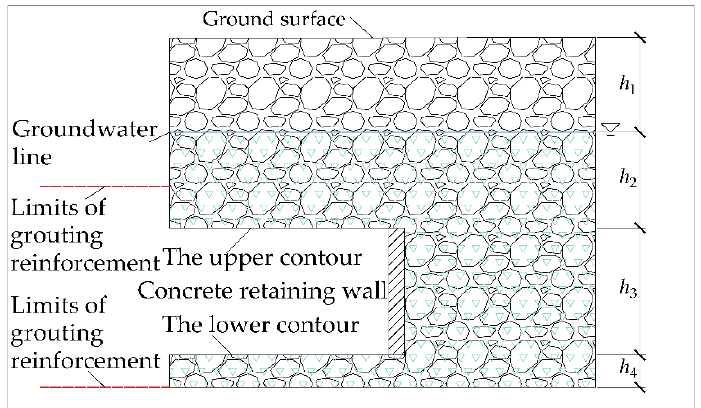
Figure 2. Diagram of the concrete retaining wall.